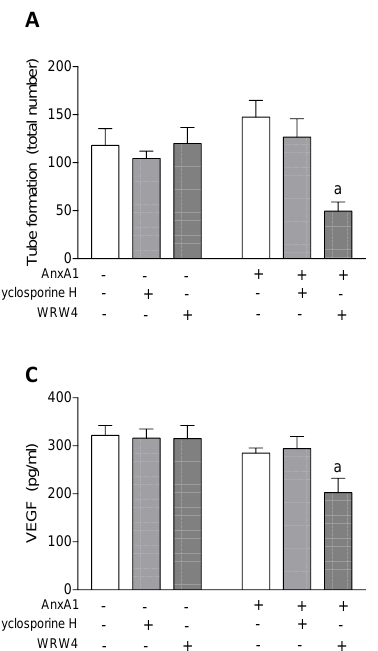
Figure 6. Supernatant of uterine epithelial cells treated with AnxA1 plus WRW 4 presented reduced levels of VEGF and reduced HUVEC tube formation. Supernatant was obtained from uterine epithelial cells previously treated with cyclosporine H or WRW 4 in the absence or presence of AnxA1. HUVEC was incubated with supernatants and tube formation was evaluated 4 h later ( A ). Representative images of tube formation are shown in ( B ). The levels of VEGF in the uterine cells supernatant were quantified 4 h after incubations ( C ). ( − ) means absence and ( + ) means presence of treatments. The data are expressed as mean ± standard error of mean of at least three to five independent experiments. a p < 0.05 vs. AnxA1.